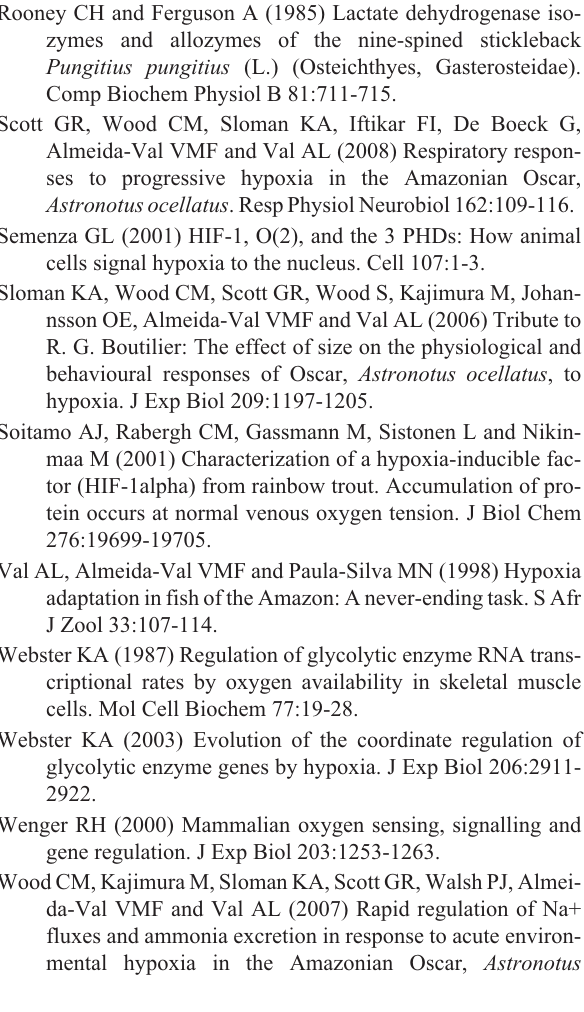
- Figure S2 - LDH-A sequence from A. cassiprinis used as a probe in Northern blotting experiments - Figure S3 - RT-PCR expression of LDH-A in Astronotus crassipinis juveniles exposed to normoxia, hypoxia and